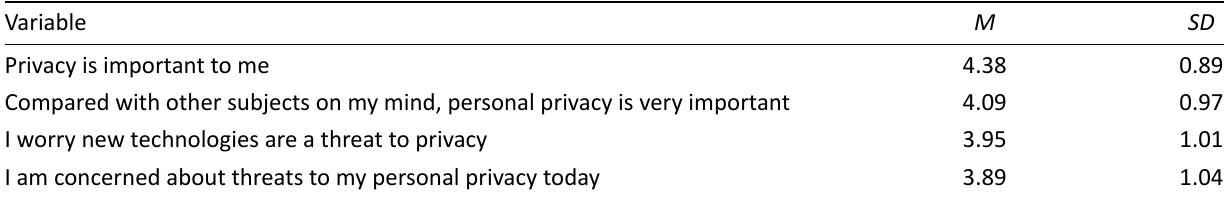
Table 2. Means of privacy concerns by scale